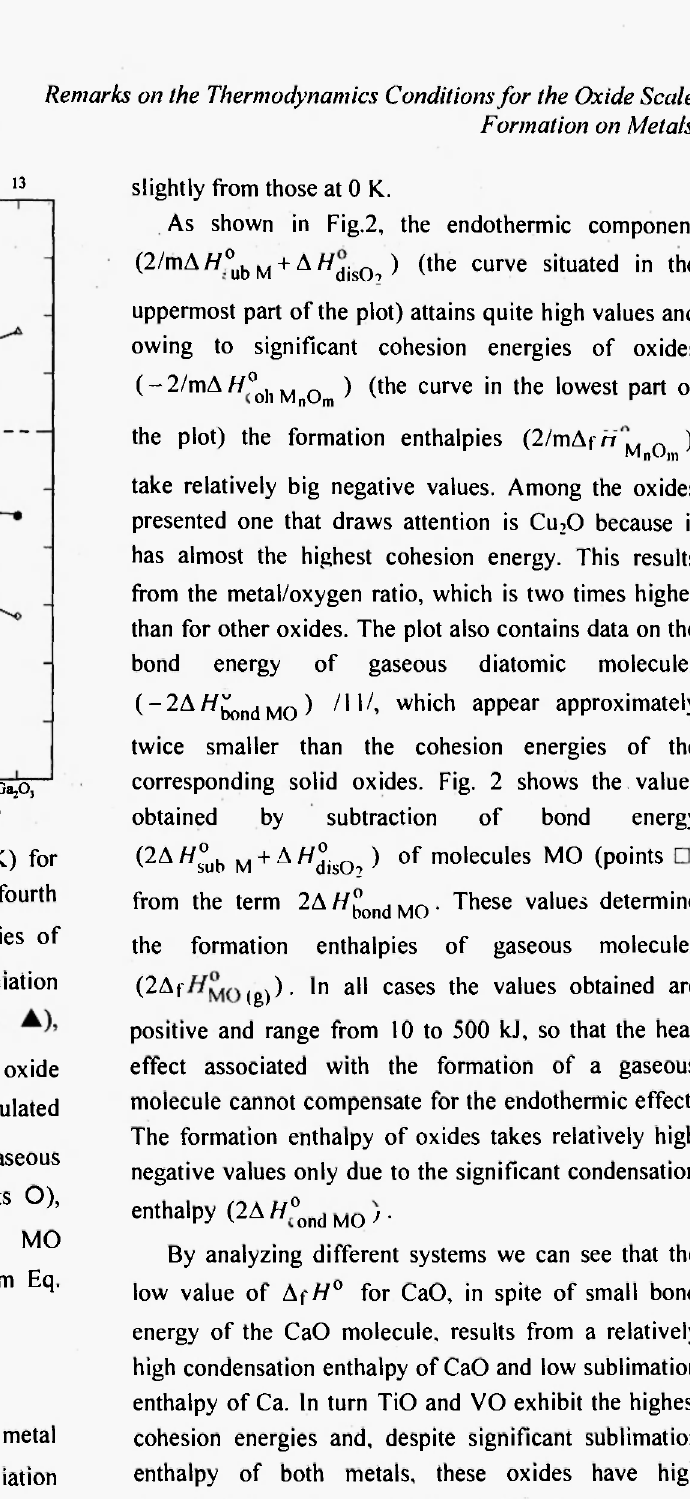
(negative) formation enthalpies Δ\·Η° . In the case of chromium and for the formation